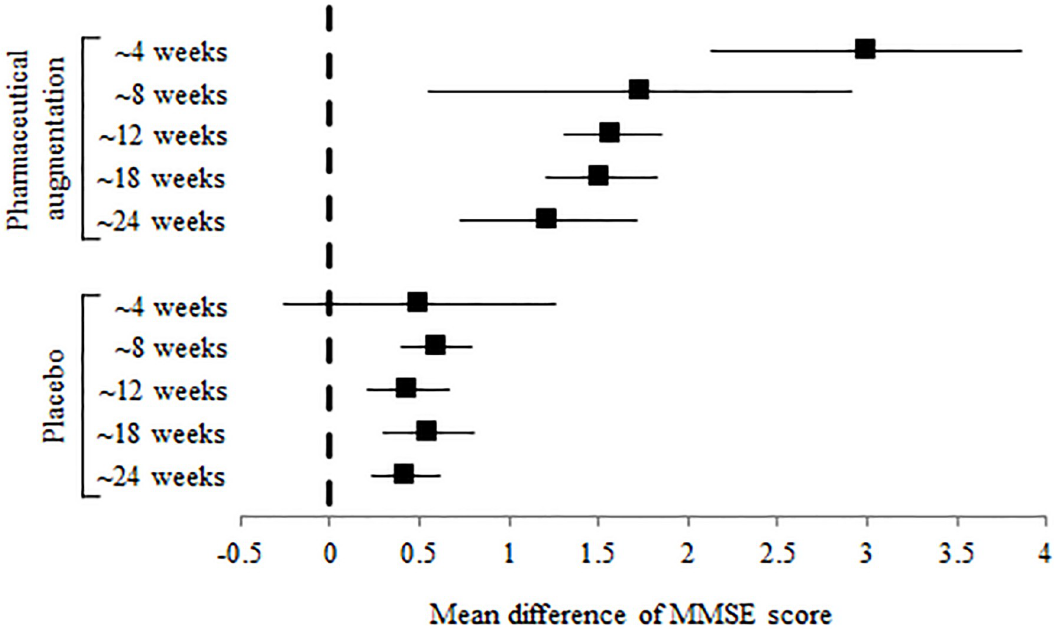
Fig 2. The mean difference of MMSE(mini–mental state examination) score according to the pharmaceutical augmentation.